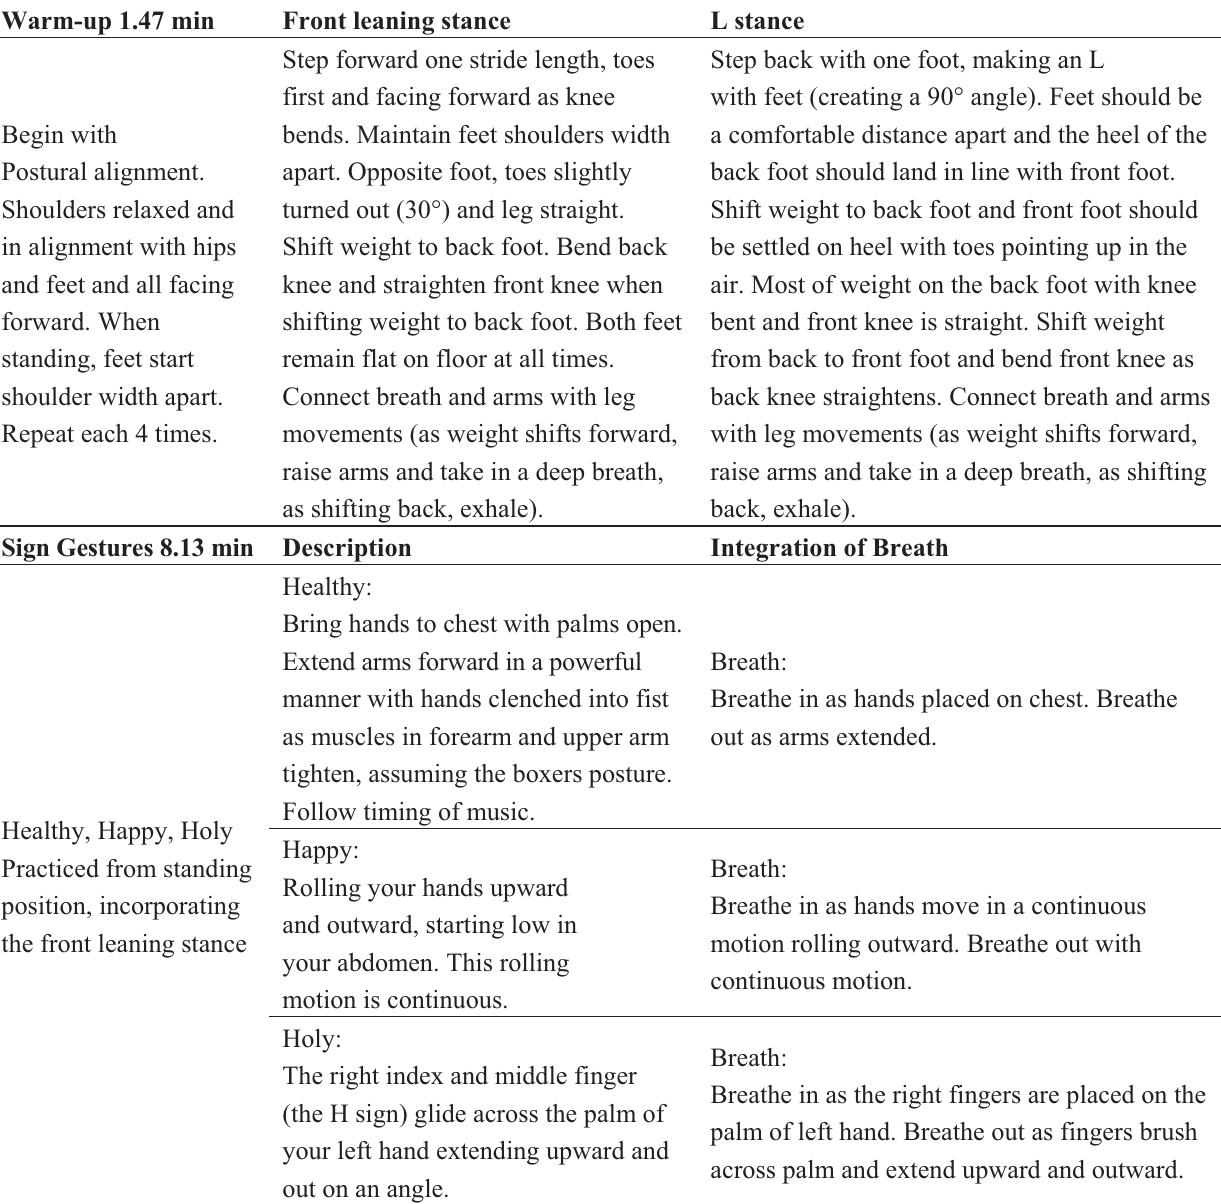
Table 1. 10-Min Sign Chi Do Exercise